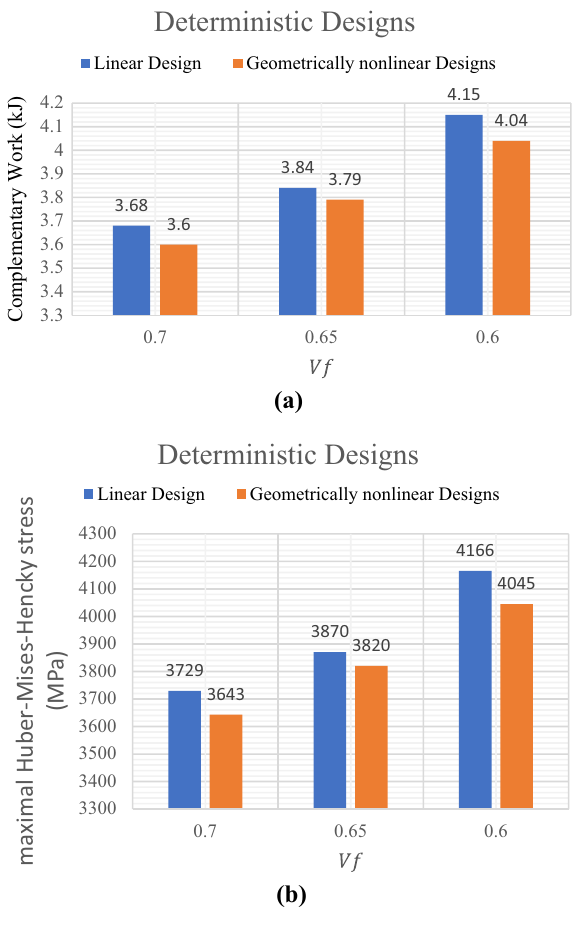
Figure 6. Comparison between linear and geometrically nonlinear deterministic design by considering: ( a ) complementary work, ( b ) maximal Huber-Mises-Hencky